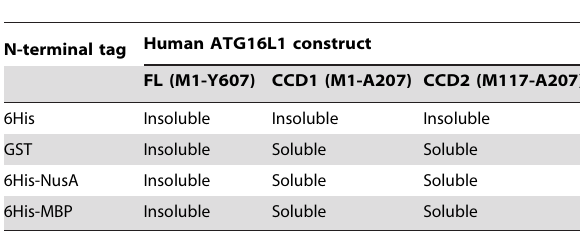
Table 1. Summary of human ATG16L1 construct expression in E.coli Rosetta TM 2